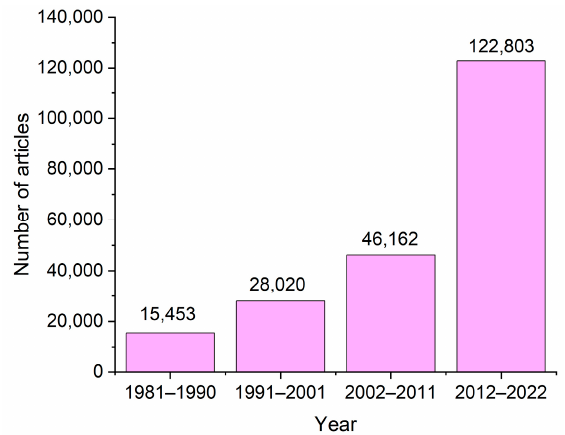
Figure 1. The number of published articles by years on the subject of gas hydrates according to the Web of Science.